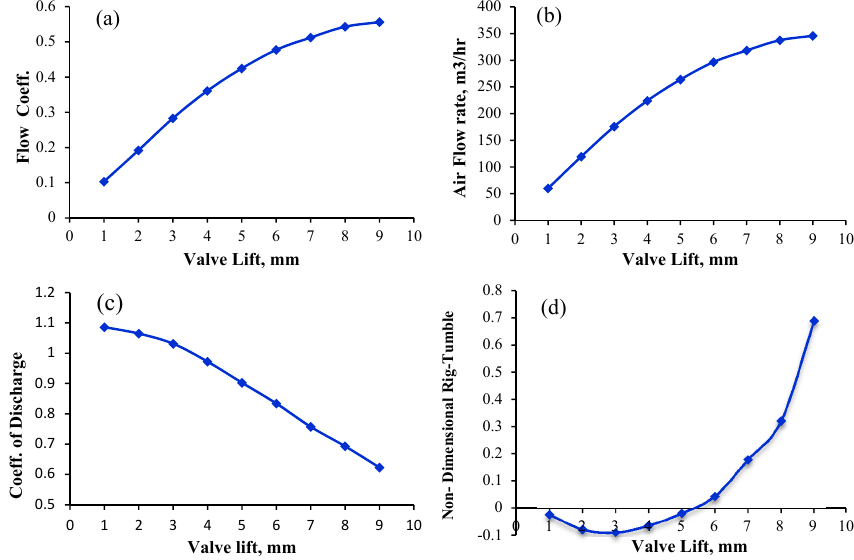
Figure 6. Integral flow parameters variation versus valve lift. ( a ) flow coefficient; ( b ) air flow rate; ( c ) discharge coefficient; ( d ) non-dimensional rig-tumble.